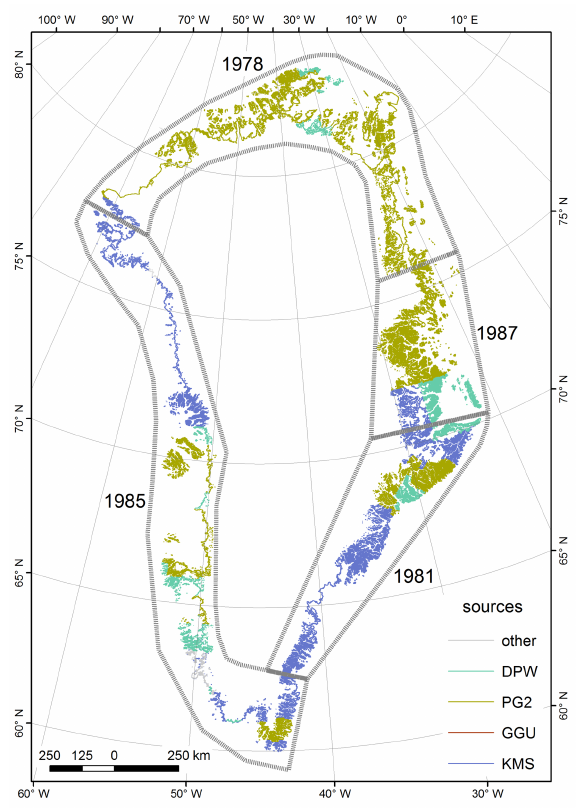
Fig. 2. Small-scale overview of the PROMICE aerophotogrammet- ric map of Greenland ice masses, colour coded according to our classification of “disconnected ice mass”, “local ice mass” (collec- tively referred to as GIC in this paper) and “ice